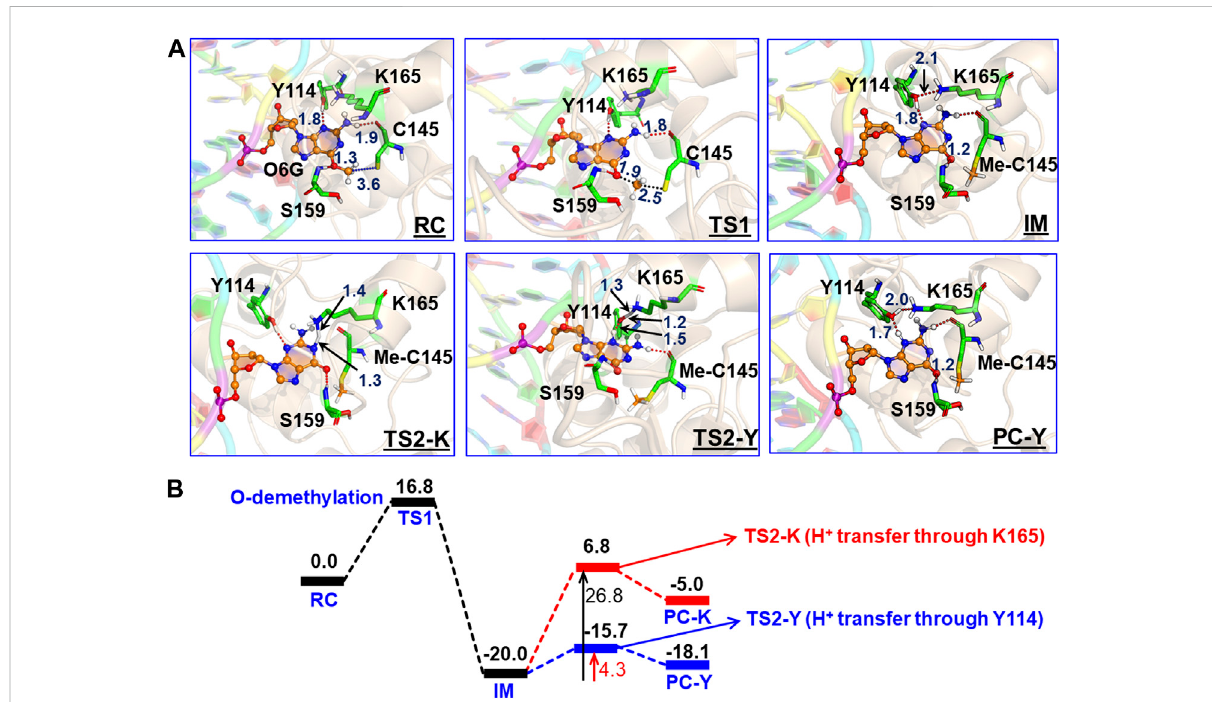
FIGURE 6 (A) QM/MM-optimized geometries along with the key geometric data for RC, TS1, TS2-Y, TS2-K, IM, and PC-Y. The geometry for PC-K can be found inSI. “ Me-C145 ” represents themethylatedCys145. (B) Complete reaction pro fi lediagram.The energyvalues(reportedinkcal/mol) are noted for the optimized structures (B3LYP/def2-SVP) of all the RC, TS, IM, and PC states. All energies are corrected by zero-point energy (ZPE) and Grimme ’ s dispersion (G-D3).